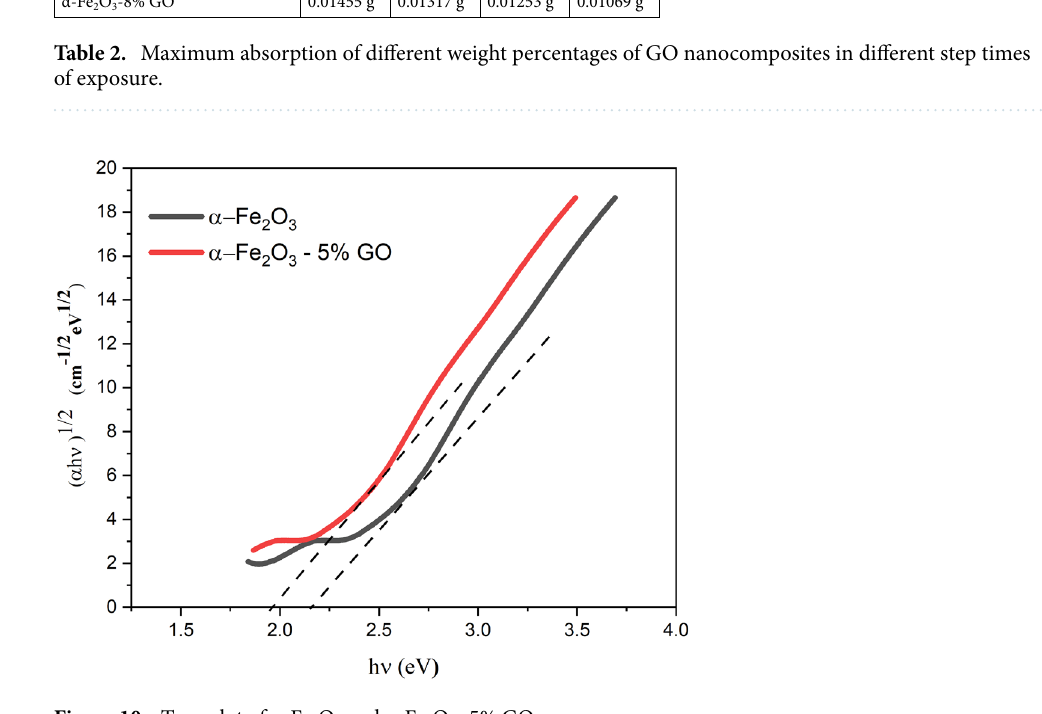
Figure 10. Tauc plot of α-Fe 2 O 3 and α-Fe 2 O 3 - 5%